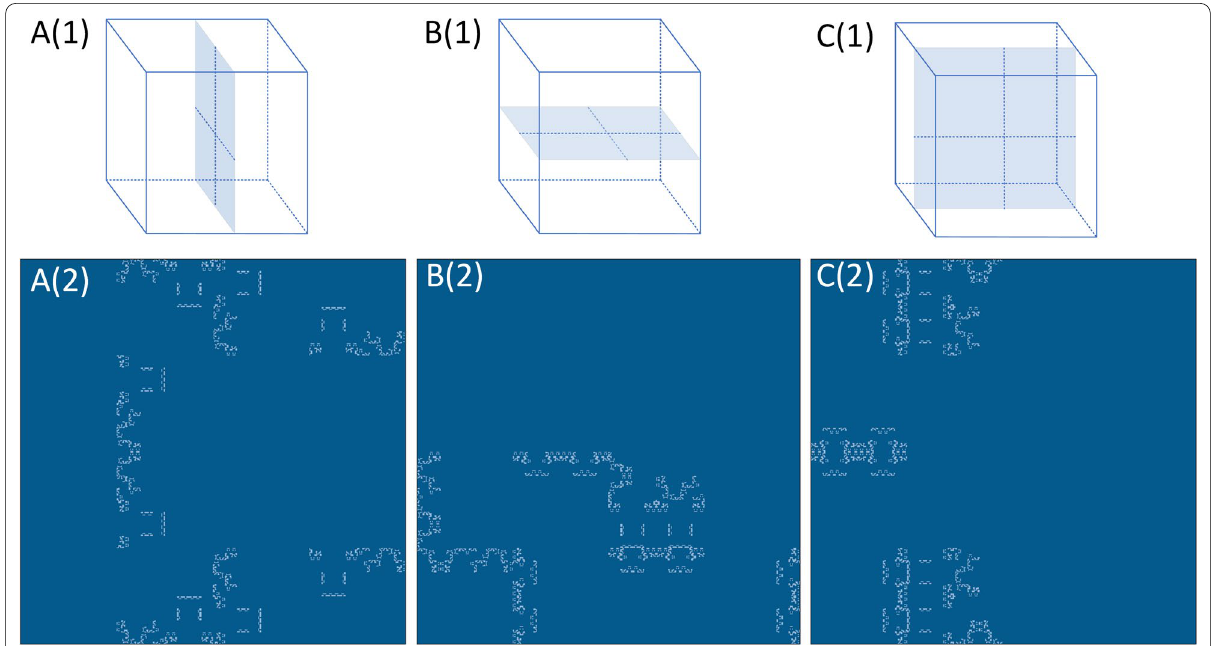
Fig. 5 The Hilbert volumes containing only a single image (the first row). The corresponding expansion to a Hilbert matrix demonstrated by the proposed Hilbert curve-based mapping approach (the second row)